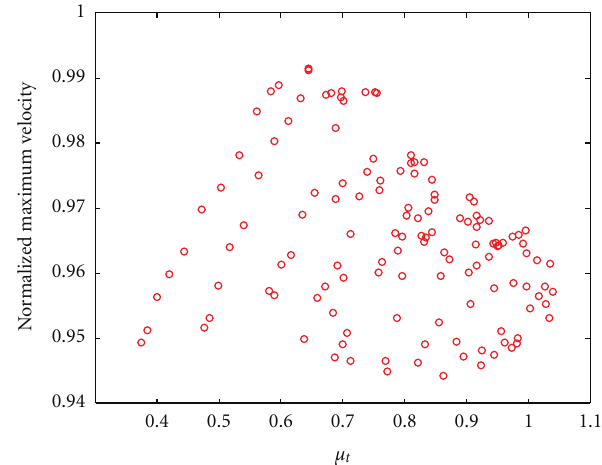
Figure 22: Scattered diagram of manipulability μ t versus velocity along the X direction (horizontal half-plane XY with Z = − 900 mm).